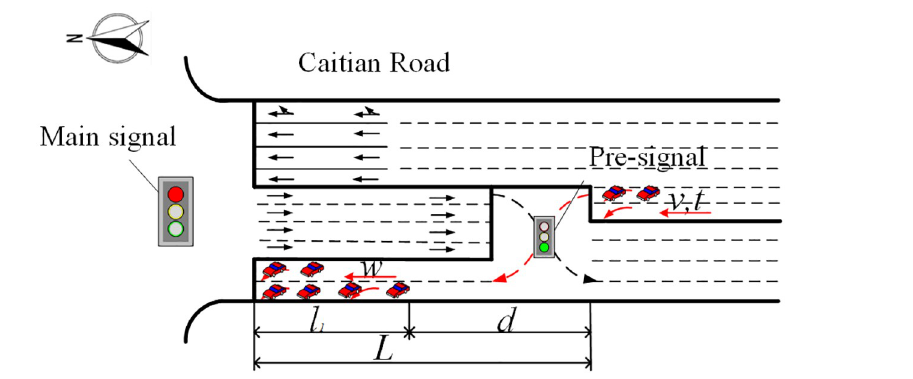
Fig 7. Vehicles entering the displaced left-turn lanes at the pre-signal of CFI.